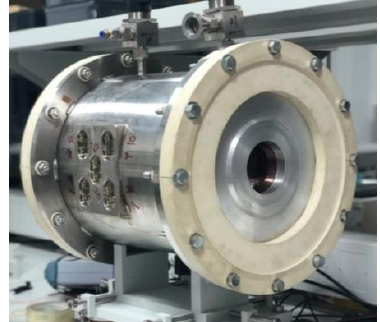
Fig.5. Schematic and photo for the FIXM spectrometer